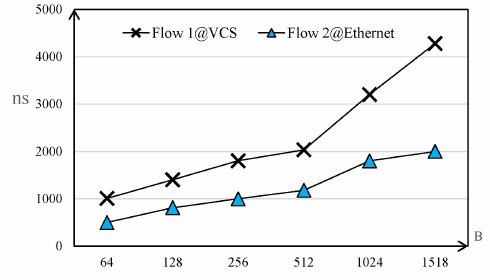
Figure 13. FCT in VCS and